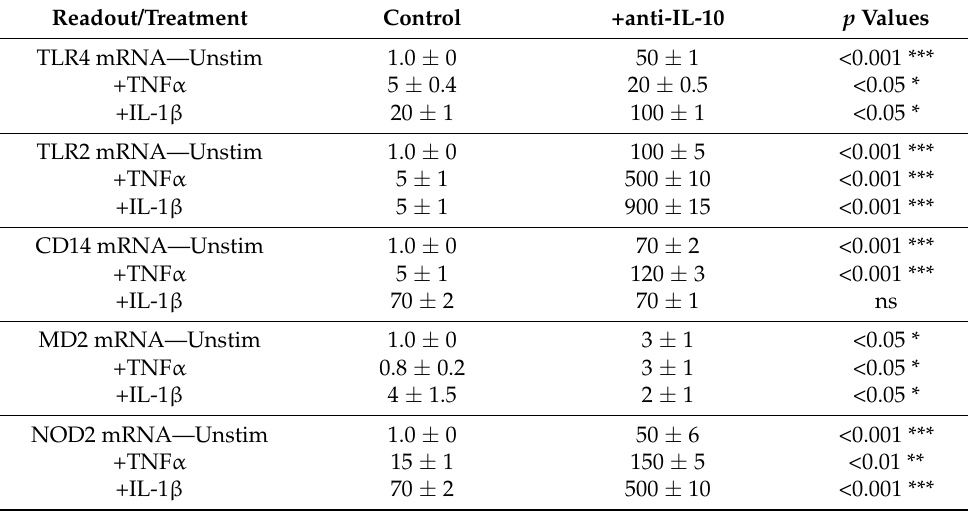
Table 4. Intestinal epithelial cell endogenous IL-10 activity regulates bacterial sensing molecules dependent on inflammatory